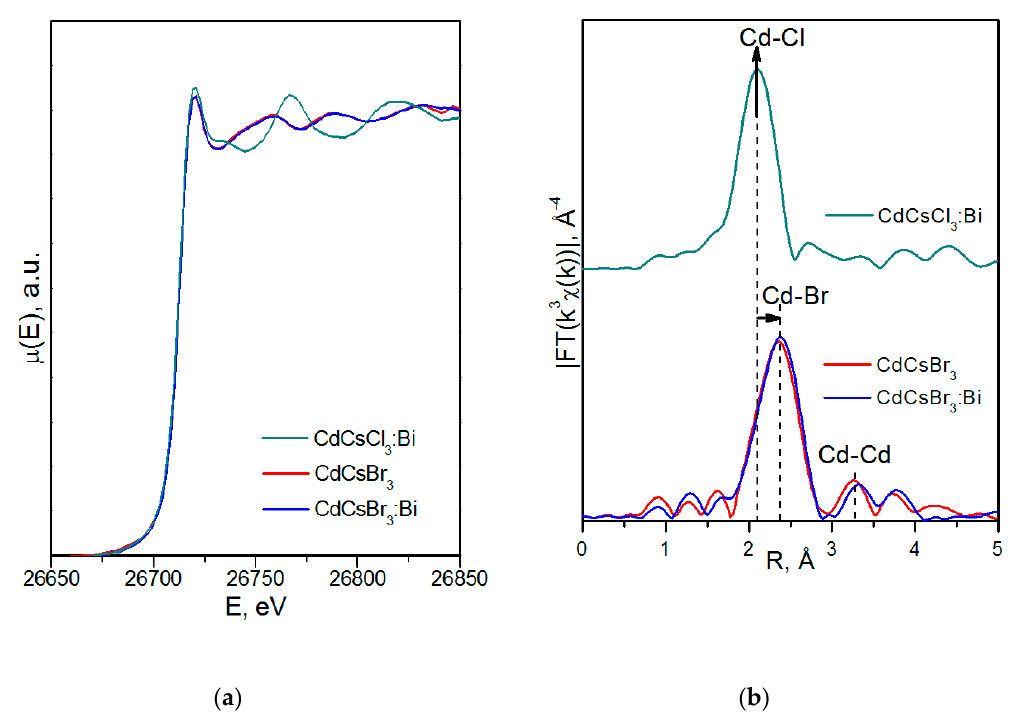
Figure 15. Cd K-edge ( a ) XANES spectra and ( b ) EXAFS Fourier transforms for the. CsCdBr 3 , CsCdBr 3 :Bi and CsCdCl 3 :Bi samples. Table 10. Results of EXAFS fit at the Cd K-edge for the CsCdBr 3 , CsCdBr 3 :Bi and CsCdCl 3 :Bi crystals: coordination number, CN; interatomic distance between the central atom and the next neighbors (the length for single scattering path), d , Å; the Debye–Waller factor, σ 2 ; the convergence factor, R f